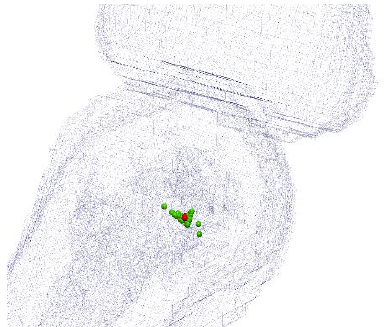
Figure 3. Estimation of the rotation center ( red ) of a joint as the centroid of finite joint centers ( green ).